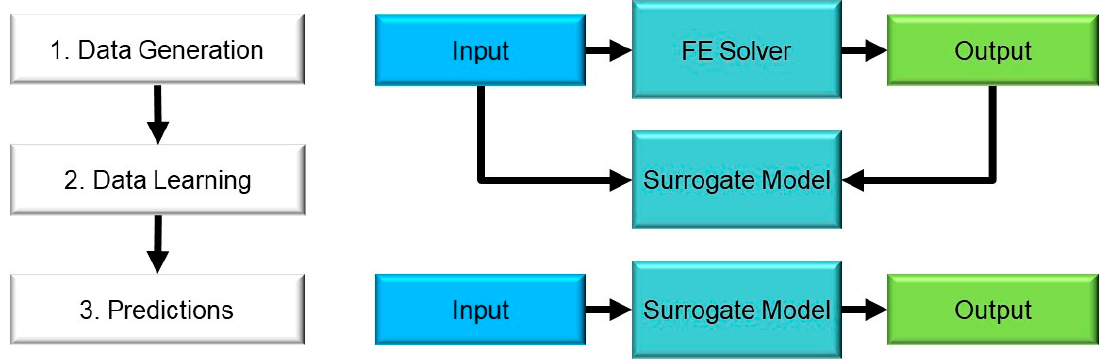
Figure 2. Stages for creating and implementing a surrogate model.